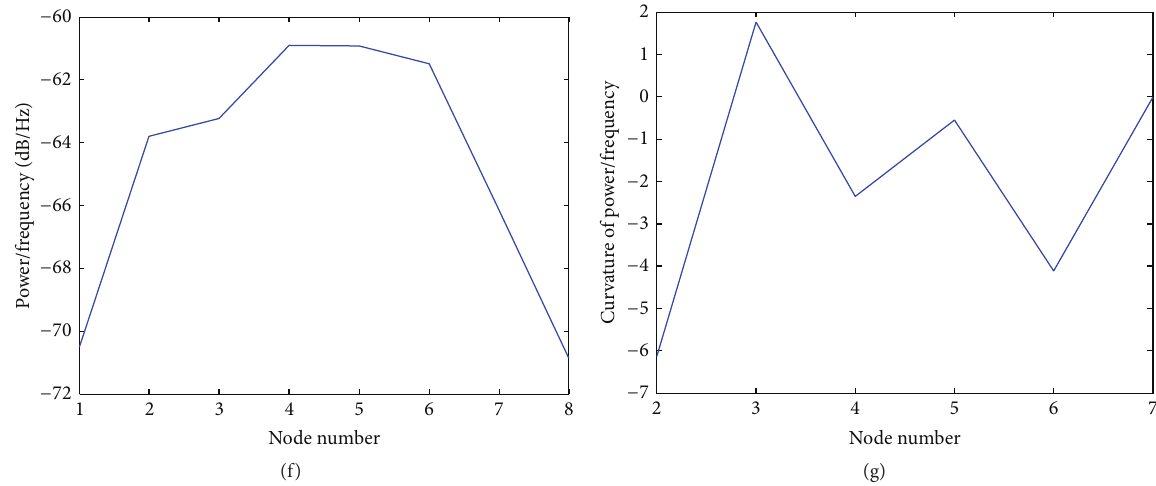
Figure 12: Experimental results: (a) acceleration responses in time-domain, (b) absolute values of FFT in frequency-domain, (c) PSE curves, (d) maximum values of FFT nearby the first resonance frequency, (e) their curvature, (f) curve of maximum PSE, and (g) its curvature.